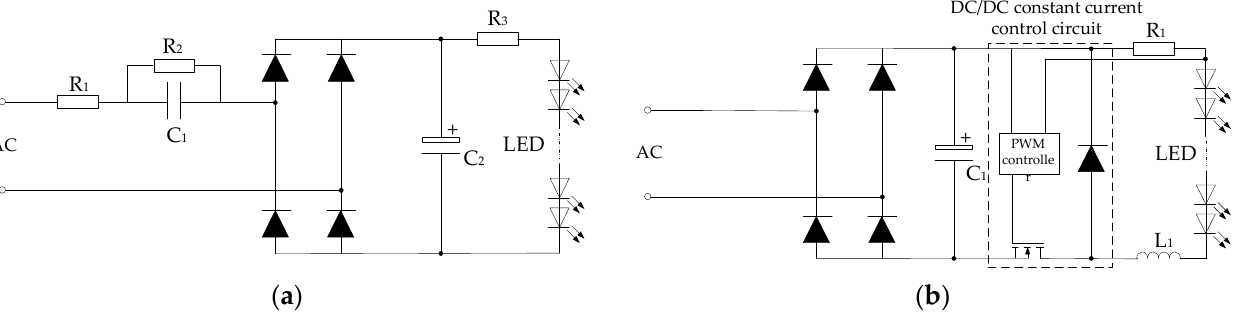
Figure 6. Schematic of common LED lamp driving types: ( a ) type I: RC buck drive; ( b ) type II: constant current drive.